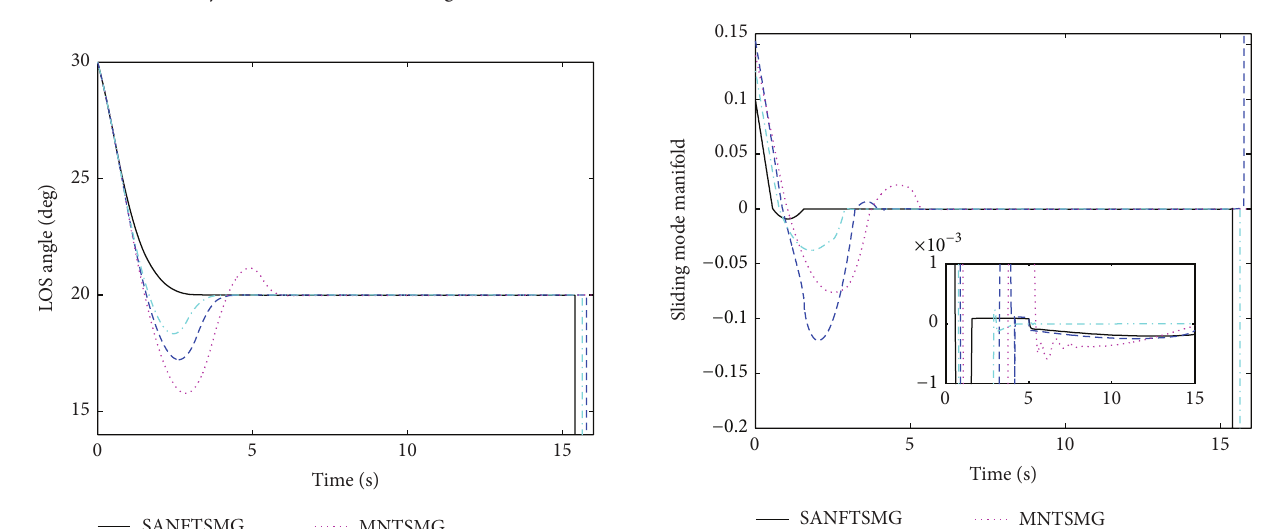
Figure 23: Trajectories of missile and target (Case 2).